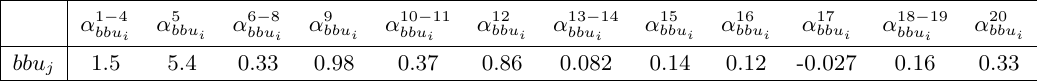
Table 4 . Coe(cid:14)cients 10 (cid:0) 2 of the master equation (2.18), in TeV 4 , HL-LHC. See text for the (cid:2) de(cid:12)nition of the signal region.